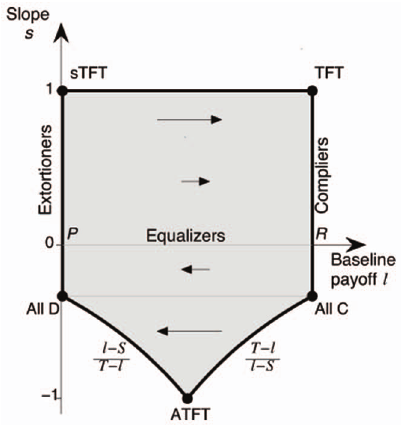
Figure 2. Adaptive dynamics in the ( l , s ) -plane. The grey-shaded state space represents the set of all enforceable linear relations that fulfill the inequalities (6). The corners of this state space consist of the payoff relations ( l , s ) that correspond to the five strategies Always Cooperate ( AllC ), Tit-for-Tat ( TFT , which starts with cooperation, and then repeats the opponent’s previous move), Suspicious Tit-for-Tat ( sTFT , which starts with defection and then repeats the opponent’s previous move), Always Defect ( AllD ), and an Anti-Tit-for-Tat strategy ( ATFT , which always plays the opposite of the opponent’s previous move). Three special subsets of this state space are of particular interest: (i) Extortioners are strategies for which l ~ P and s w 0 . (ii) Equalizers are strategies with s ~ 0 (iii) Compliers correspond to the edge l ~ R and s w 0 . The grey line between AllD and AllC corresponds to the set of linear relationships that can be enforced with unconditional strategies (in particular it follows that all unconditional strategies enforce linear relationships with a negative slope, see Methods section). The adaptive dynamics for this system is surprisingly simple: orbits are parallel to the l -axis; for s w 0 , they converge towards the edge of compliers, whereas for s v 0 , they converge towards the left boundary of the state space. Parameters: T ~ 3 , R ~ 2 , P ~ 0 , S ~{ 1